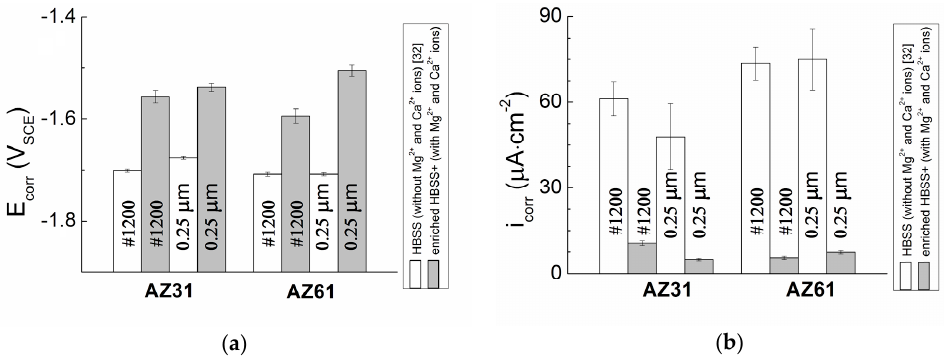
Figure 8. Comparison of ( a ) E corr and ( b ) i corr of ground (#1200) and polished (0.25 µm) surface AZ31 and AZ61 magnesium alloys in enriched HBSS+ (with Mg 2+ and Ca 2+ ions) and in HBSS (without Mg 2+ and Ca 2+ ions [32]).